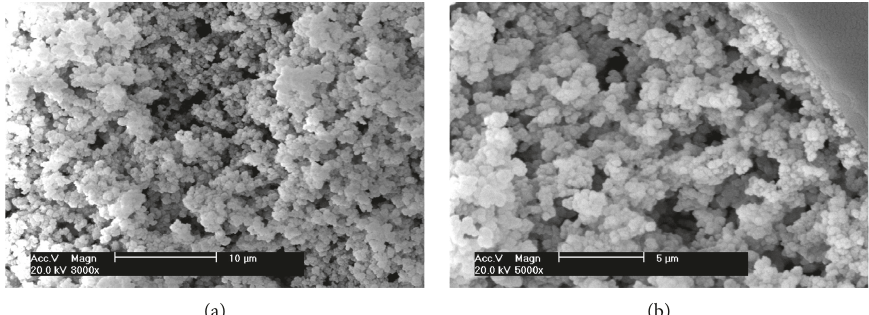
Figure 1: SEM of the end of the MIP monolithic stationary phase in a fused-silica capillary column.